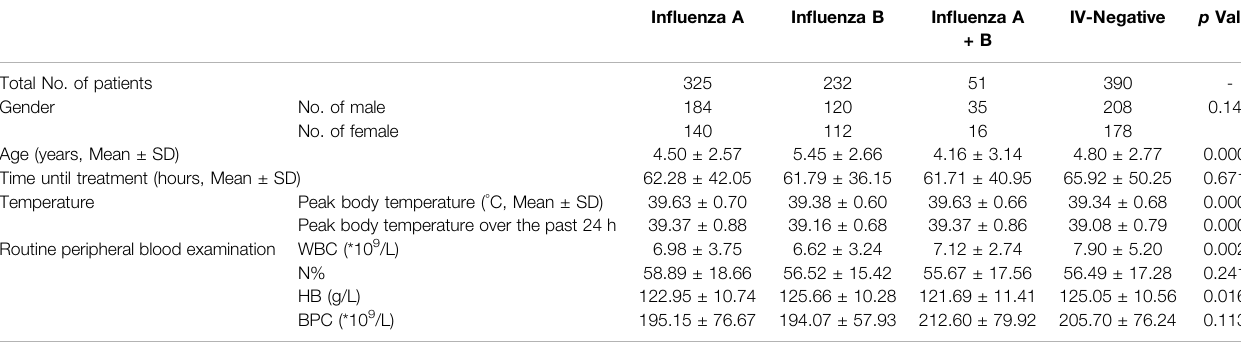
TABLE 1 | Characteristics of children patients enrolled in this study.